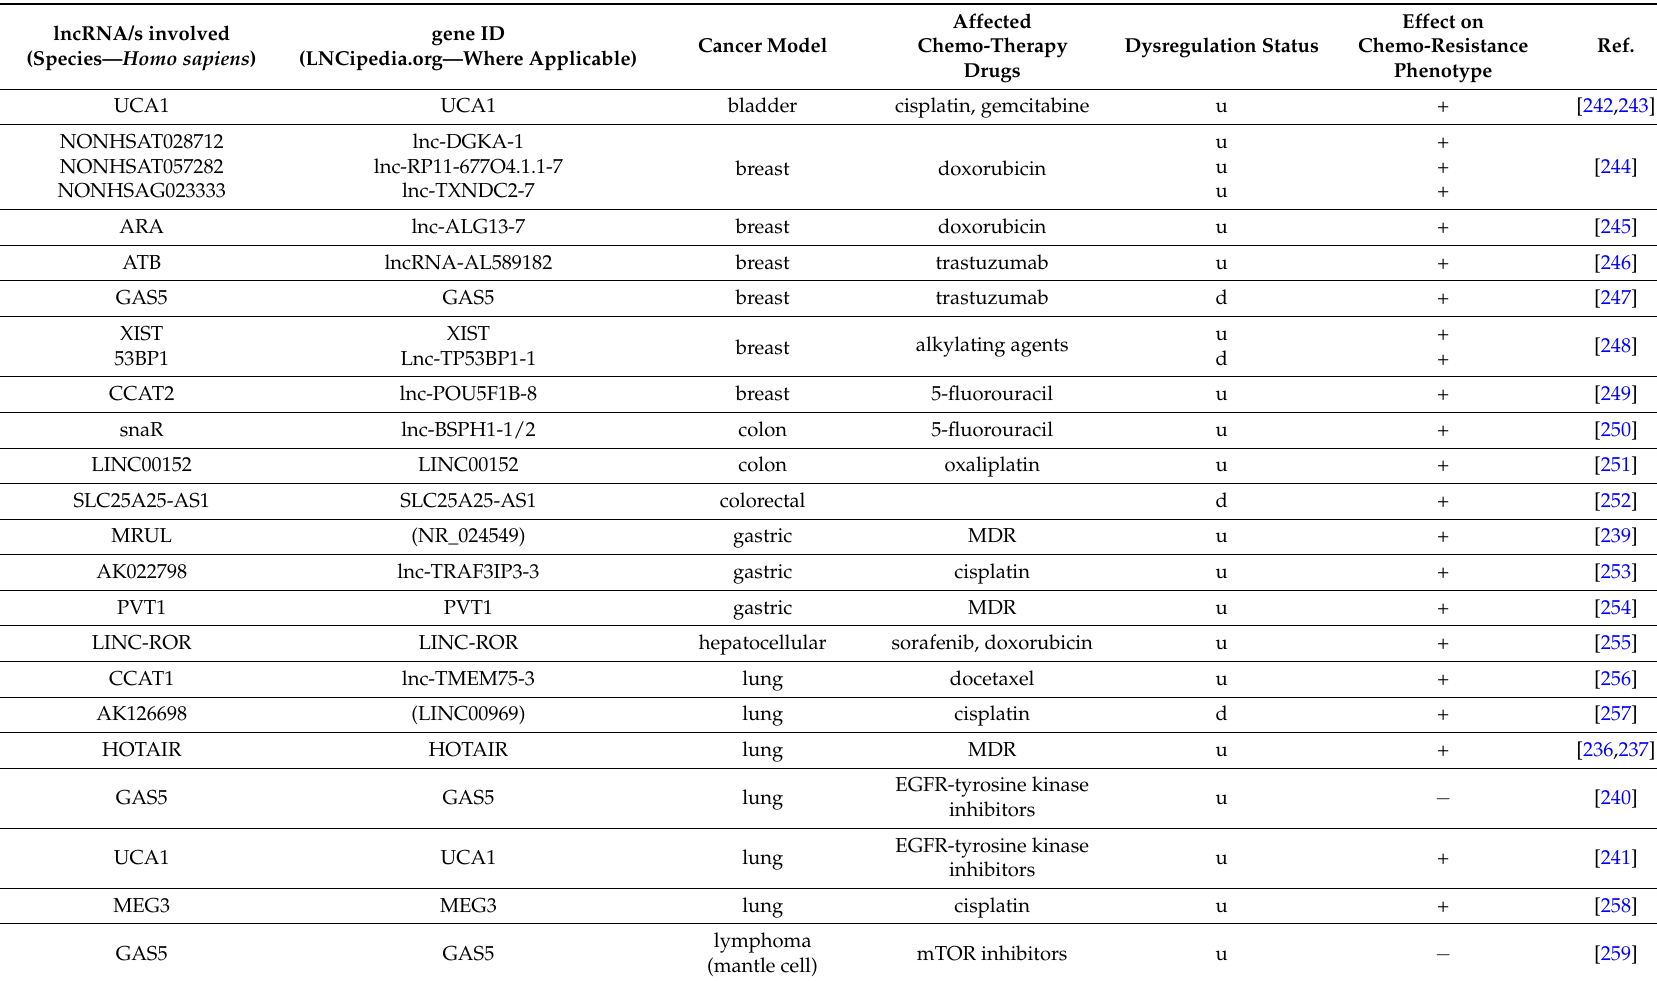
Table 2. Compendium of lncRNAs identified to influence cancer chemoresistance, either as oncogenic lncRNAs or as tumour suppressors. Table keys: u, Upregulated; d, Downregulated; +, Exacerbation; − ,